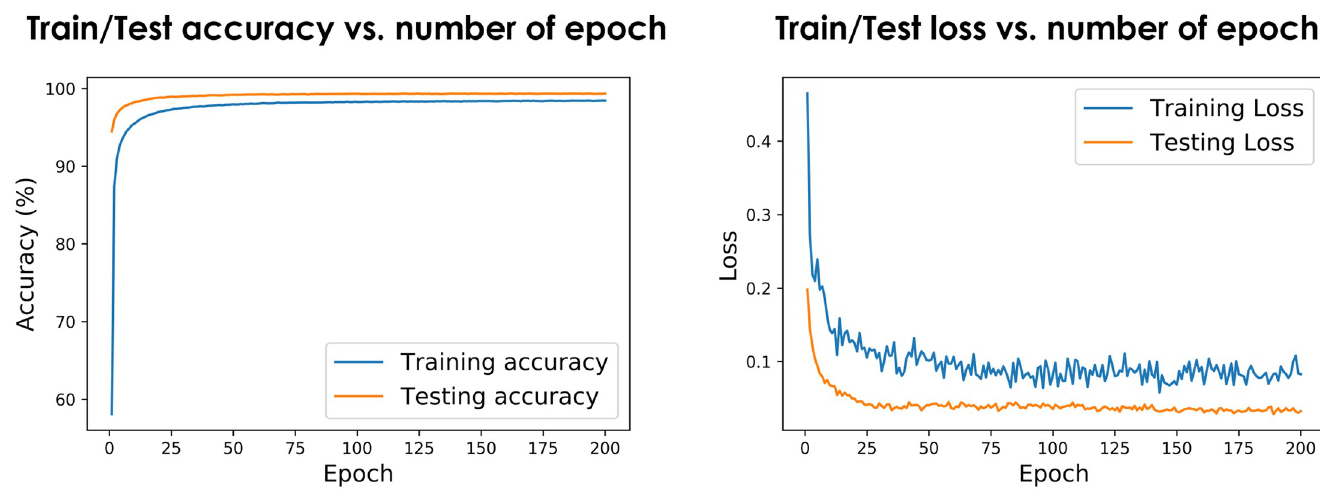
Fig 6. Training progress for train/test data (left) and the loss value over time (right).